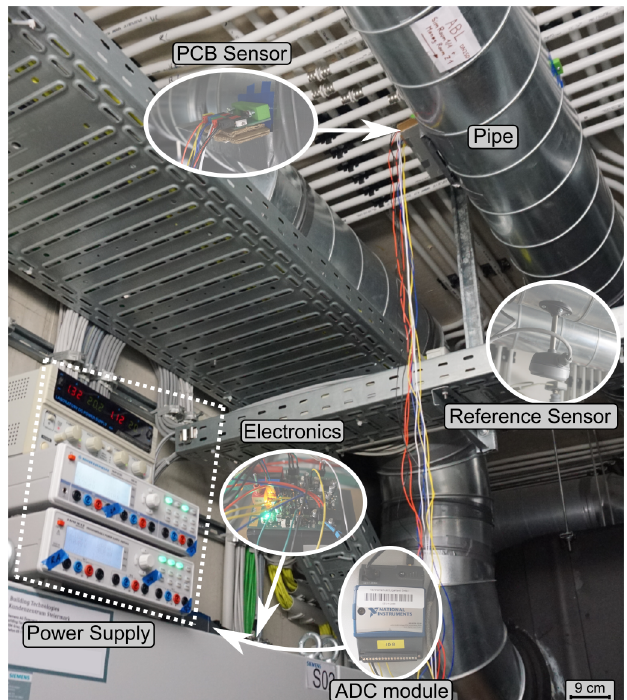
Figure 7. Measurement setup where the PCB sensor is mounted across a pipe. A reference flow sensor is located 750mm downstream of the PCB sensor. The signals from both sensors are recorded with an ADC module which sends the data via WLAN to a central server.